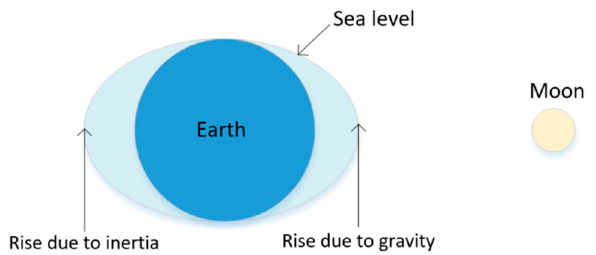
Figure 4. Effect of gravity and inertia on the sea level of Earth.